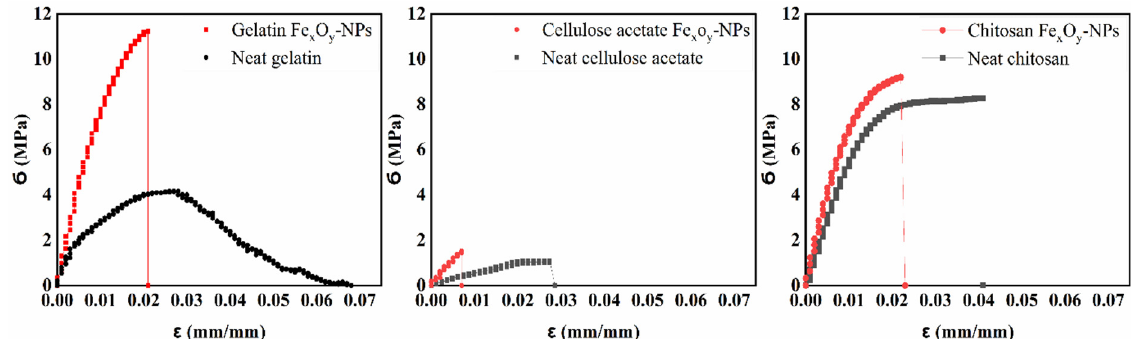
Figure 4. Photographs of the different films (gelatin-based, cellulose acetate-based, and chitosan- based composite films) with Fe x O y (1.0% w / w ). Neat films (gelatin-based, cellulose acetate-based, and chitosan-based films) without Fe x O y nanoparticles incorporated were included as references. Figure 5. Tensile test profile of the different films (gelatin-based, cellulose acetate-based, and chitosan- based composite films) with Fe x O y (1.0% w / w ). Neat films (gelatin-based, cellulose acetate-based, and chitosan-based films) without NPs incorporated were included as the reference system.